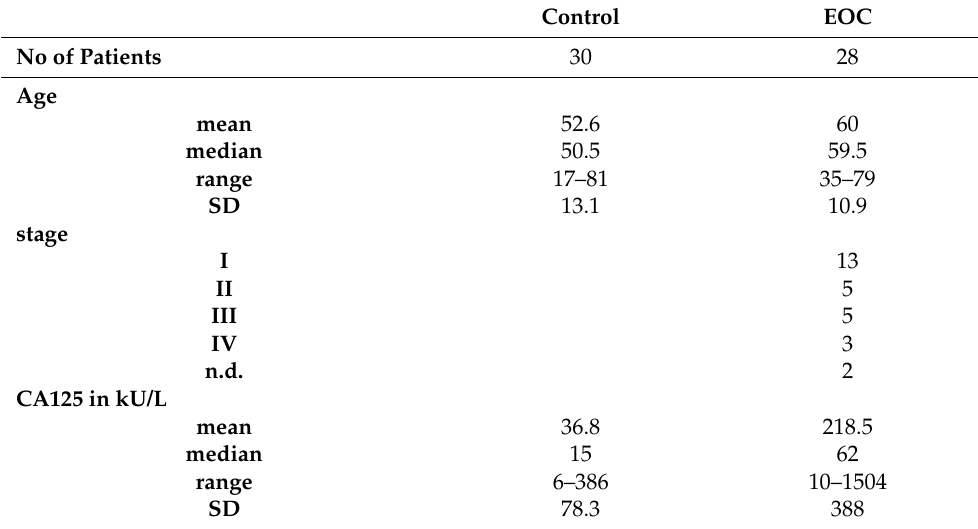
Table 1. Demographics of the cohorts used in this